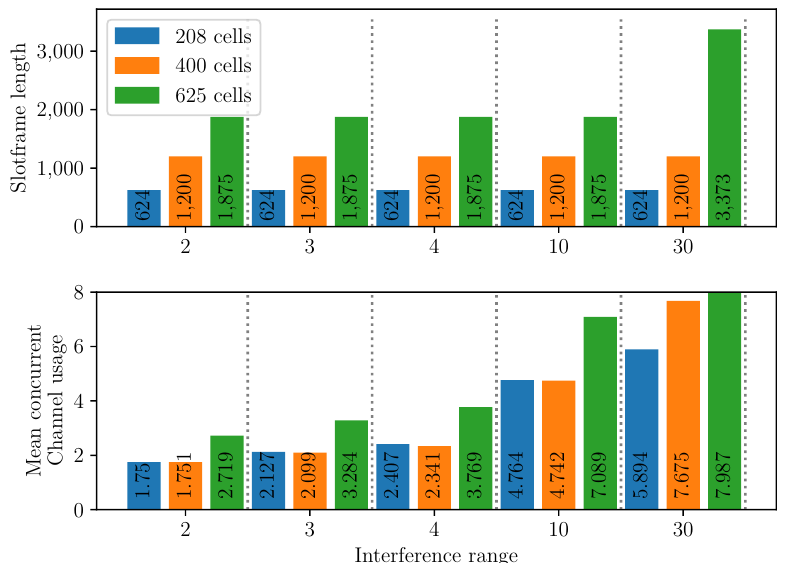
Figure 24. Slotframe length and mean concurrent channel usages according to the interference range and the size of the network. TSCH is configured with 8